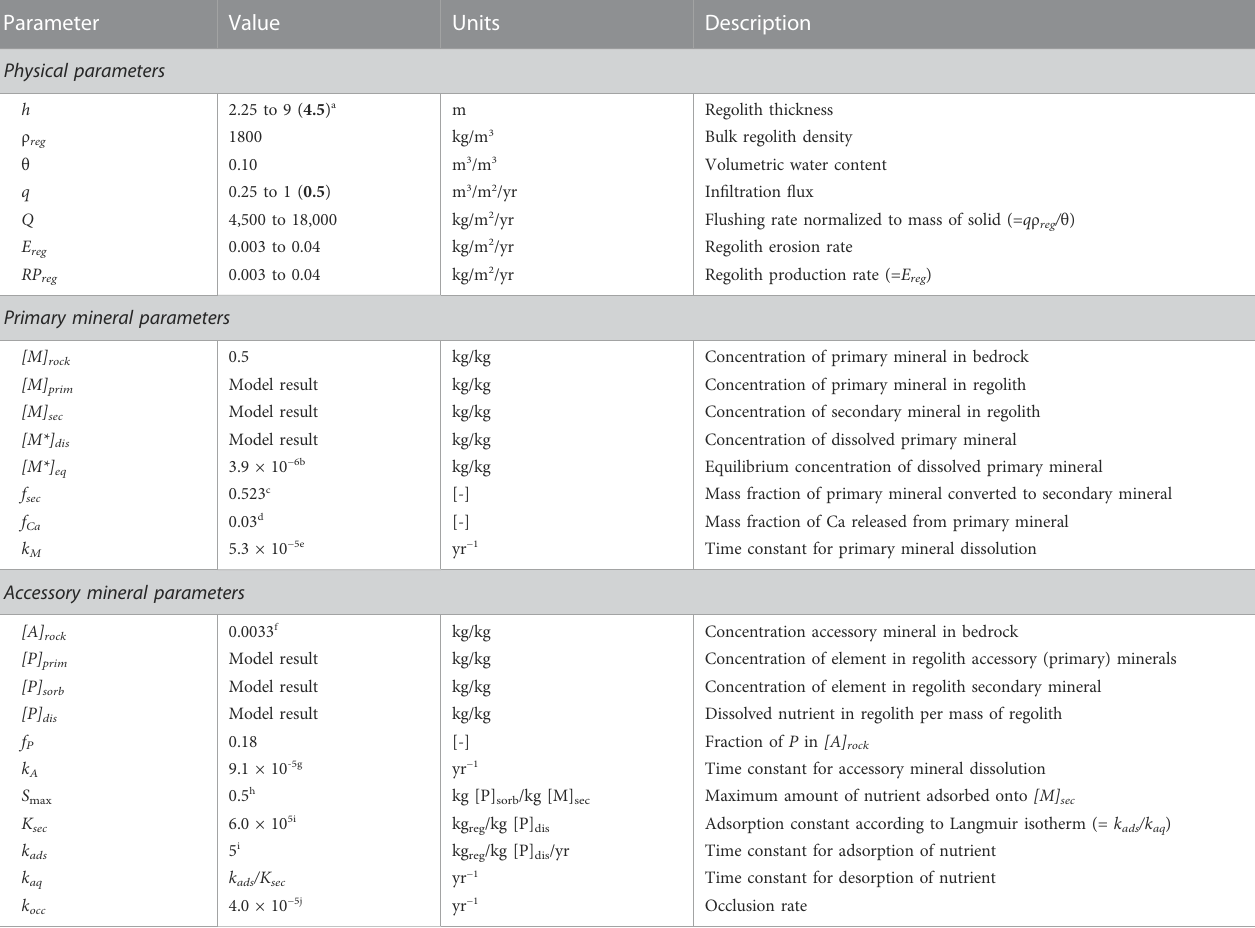
TABLE 3 Parameter values and descriptions for regolith weathering equations. Parameters computed using the model framework are designated as “ model result ” , whereas for other values the range considered is provided with the “ reference ” value in bold in parentheses. [-] denotes unitless parameter.